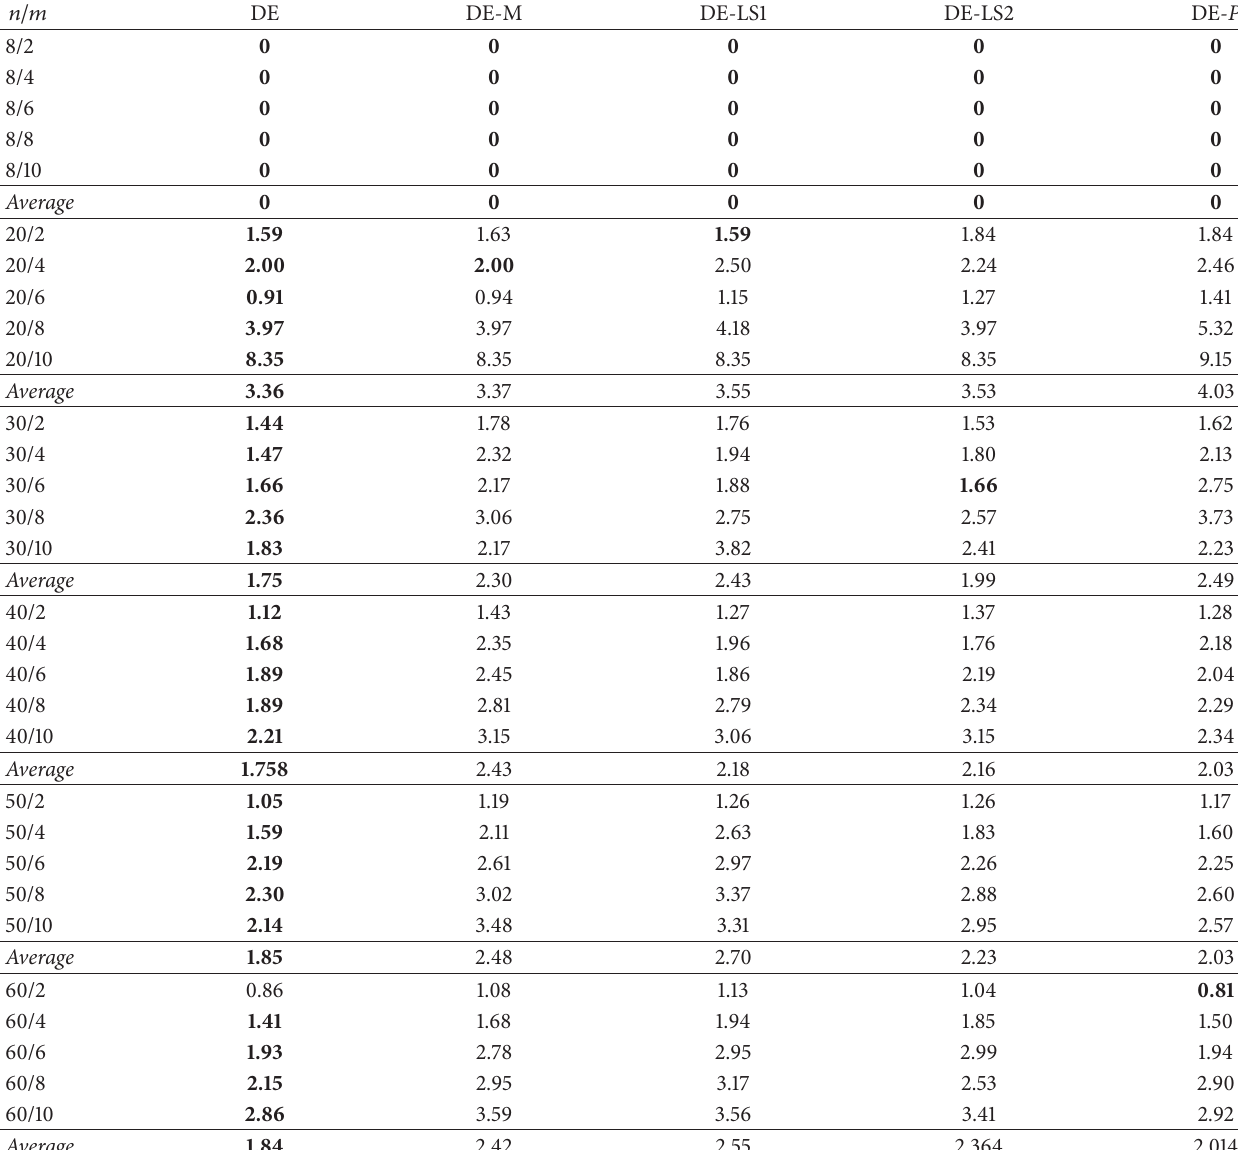
Table 5: Mean percent deviation for DE and its